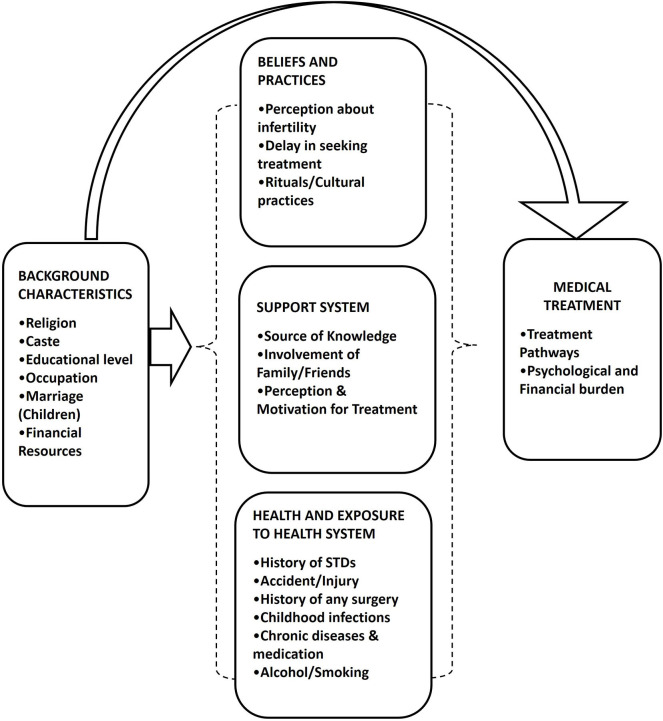
Treatment seeking framework for infertility.